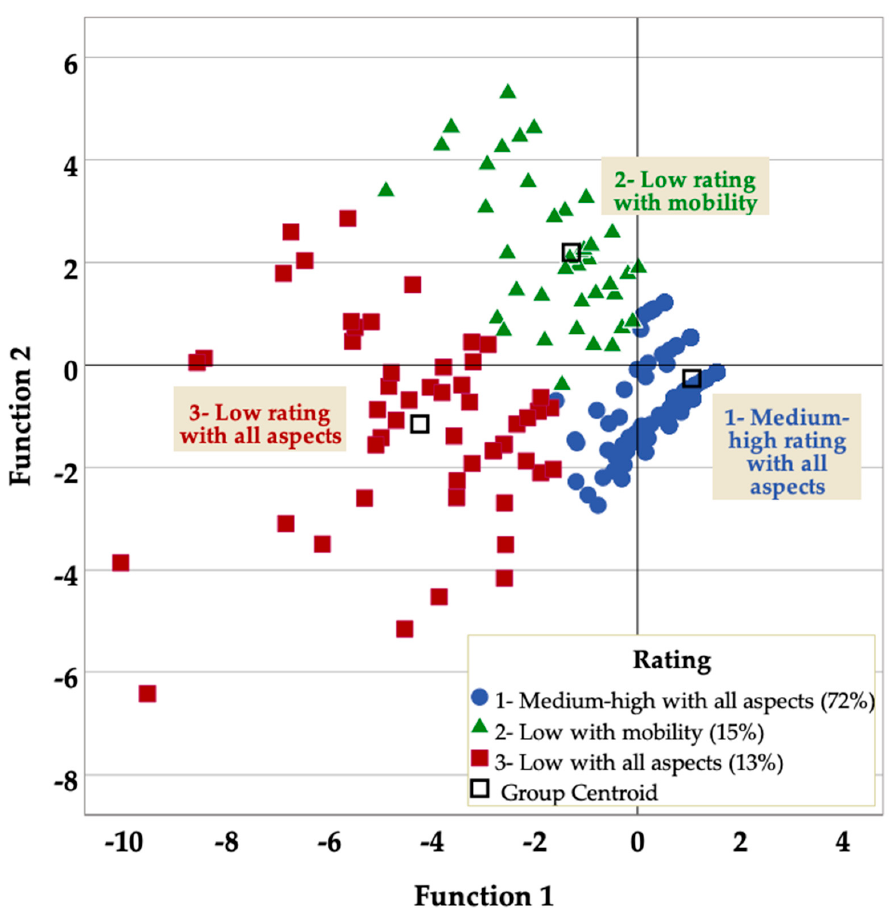
Figure 1. Grouping of subjects according to residential assessment. All-clusters scatter plot.